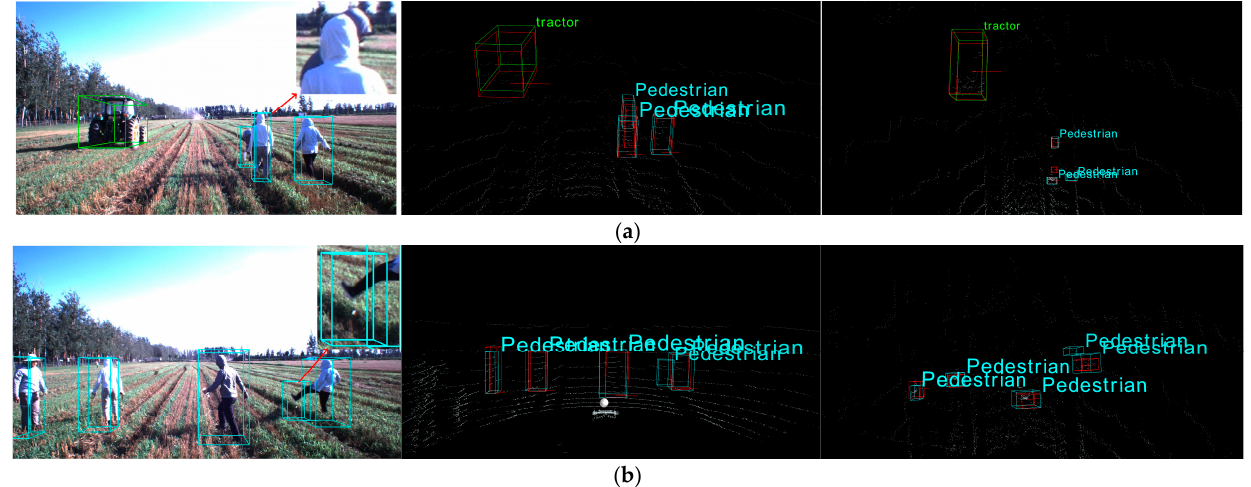
Figure 11. Typical failed detection cases. ( a ) Under occlusion. ( b ) Small targets in multiple poses.